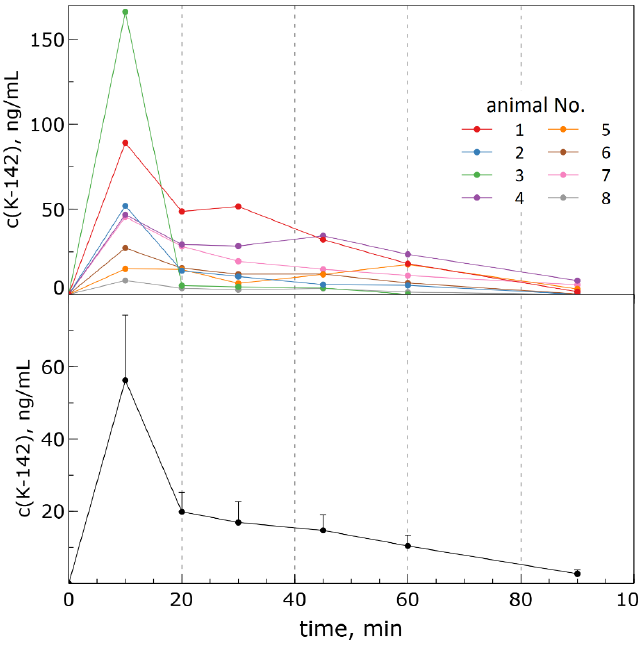
Figure 5. Concentration-time profiles of K-142 in blood after oral administration at a dose of 20 mg/kg in mice: ( A ) individual profiles for animals; ( B ) average profile (represented as mean values ± SEM).